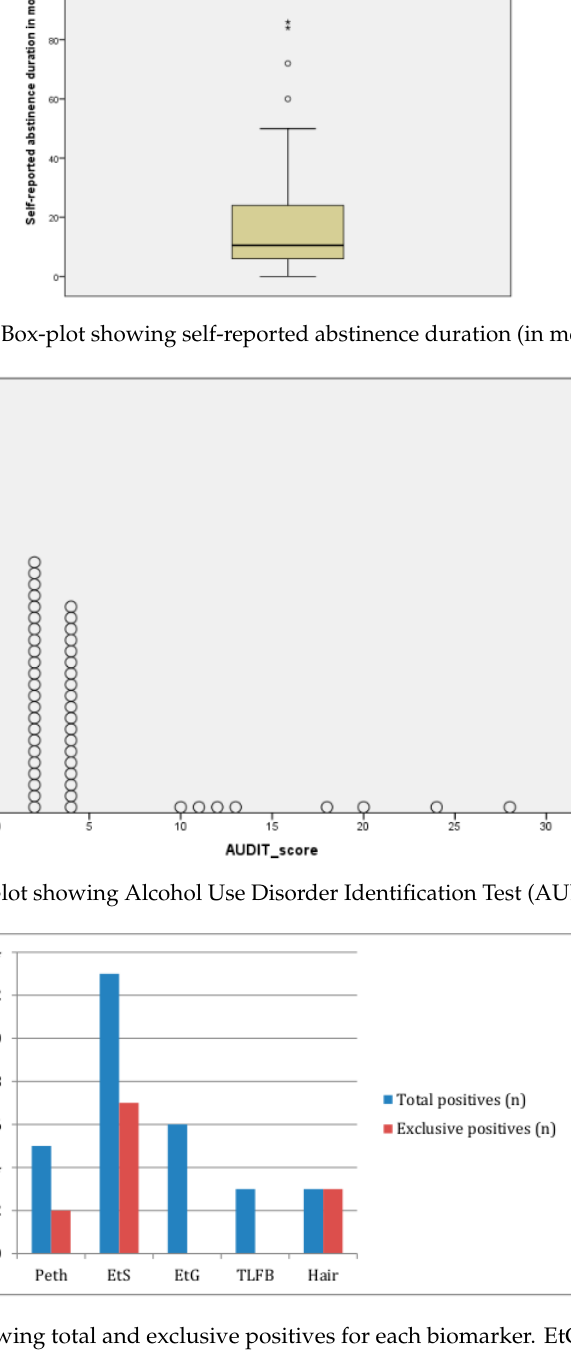
Figure 3. Barchart showing total and exclusive positives for each biomarker. EtG: ethylglucuronide; EtS: ethylsulfate; PeTH: phosphatydilethanol, HEtG: hair ethylglucuronide; TLFB: timeline follow